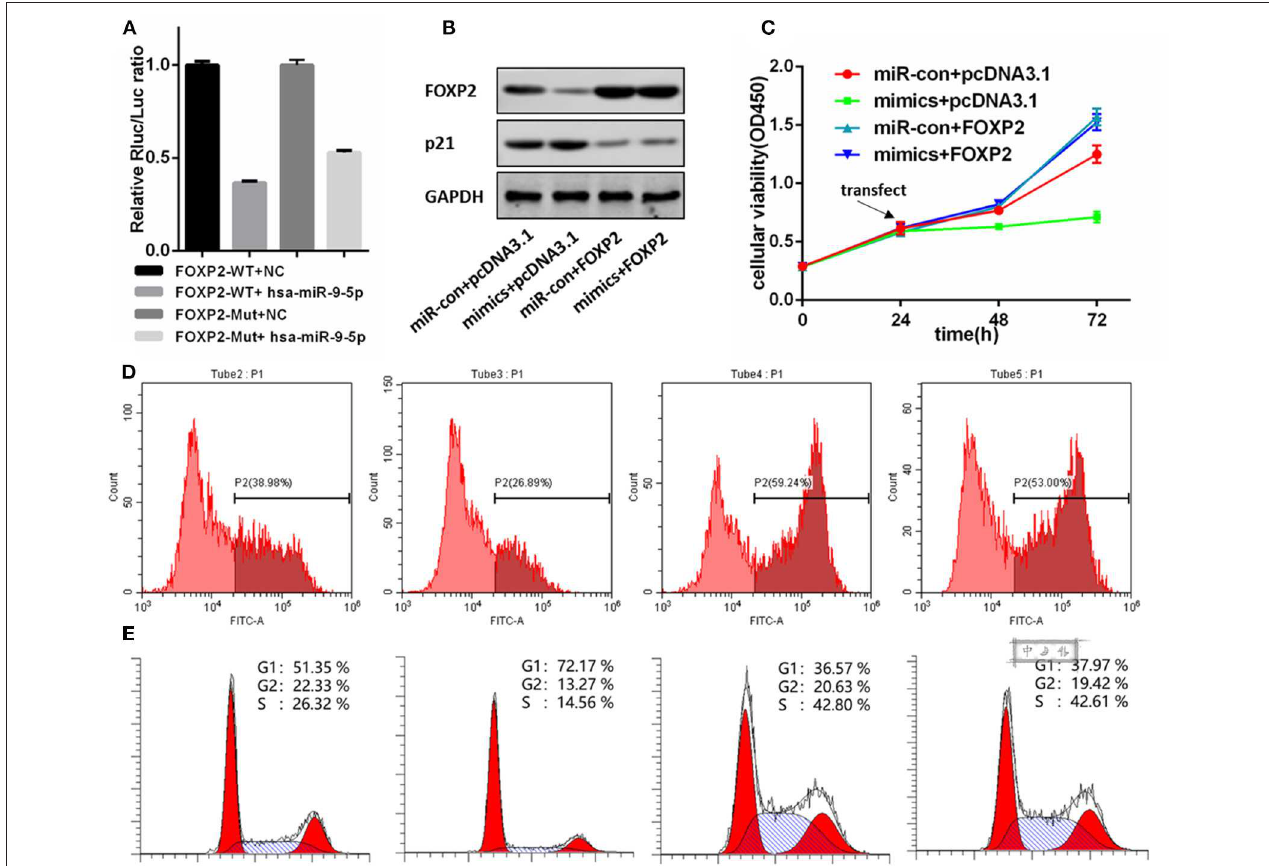
FIGURE 4 | FOXP2 is indispensable for miR-9-5p suppressing U87MG cell proliferation. (A) Luciferase reporter assay suggests FOXP2 is the direct target of miR-9-5p. (B) Western bolt shows that the DNA transfection hold back the down regulation of FOXP2. Further, the up regulation of p21 caused by miR-9-5p is also restrained. (C,D) CCK-8 (C) and EdU (D) show that cell proliferation inhibition caused by miR-9-5p is restrained by stable expression of FOXP2. (E) Cell cycle arrest is blocked by the stable FOXP2.